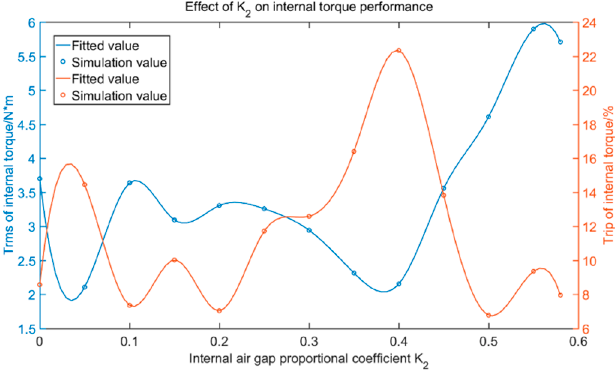
Figure 7. Relationship between K 2 and the performance of the internal torque.